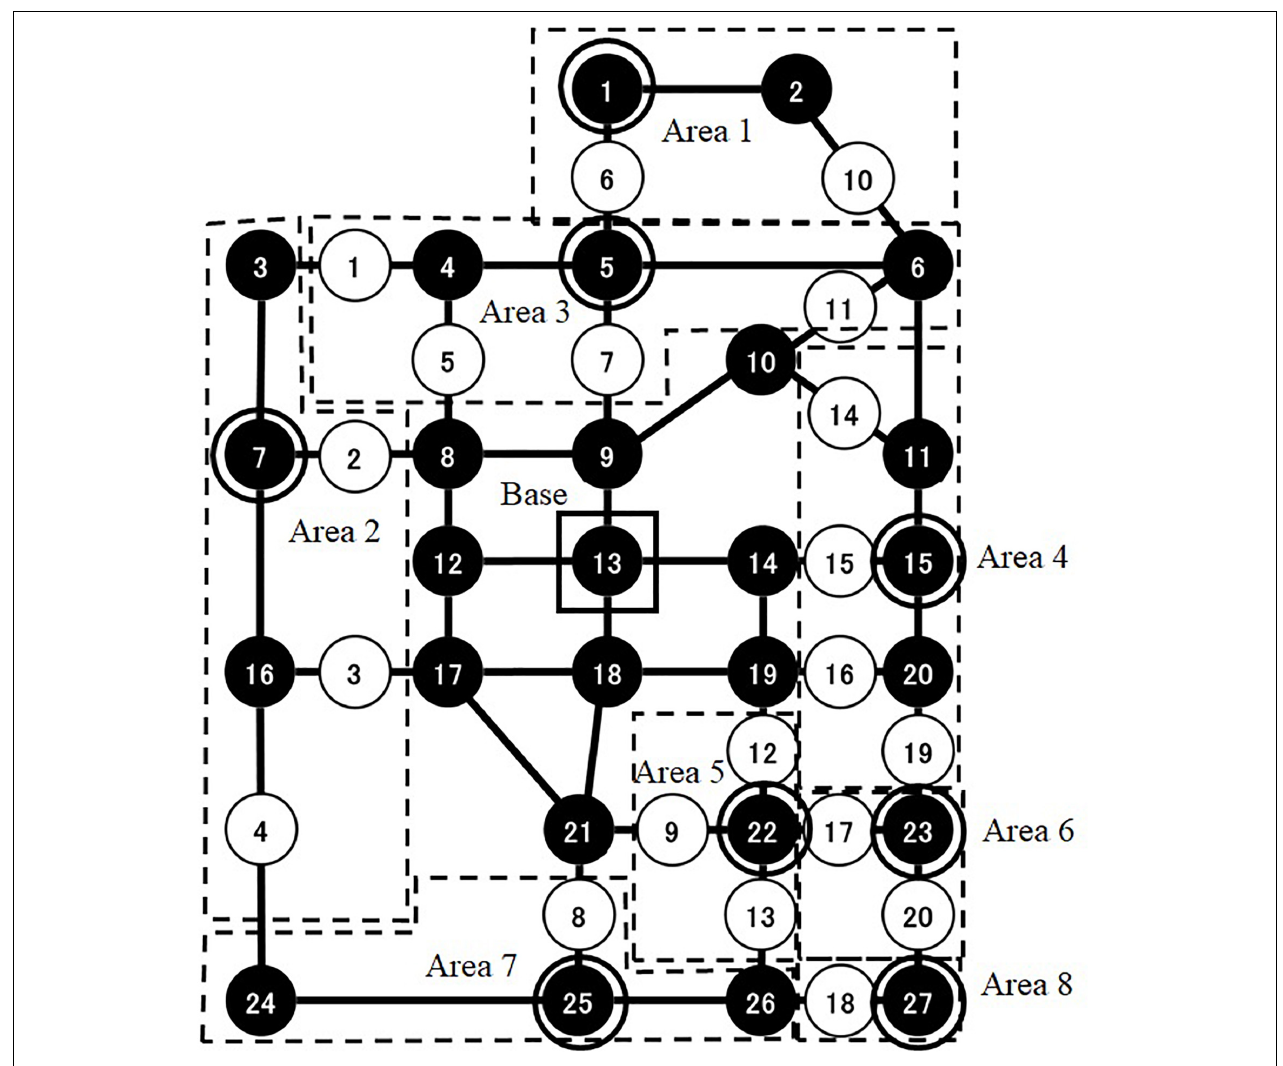
FIGURE 6 | Problem setting for emergency recovery.